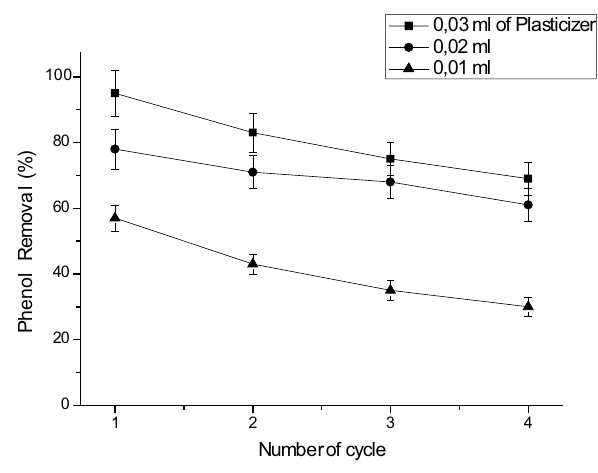
Fig. 7 Effect of plasticizer content on membrane stability. Transport conditions: feed phase: phenol 10 −3 M, pH 2. Stripping phase: NaOH 0.20 M. Membrane: 12.60 cm 2 of surface area, calix[4]resorcinarene: RC8 (0.15 g/g mixture of polymers), 2-NPOE(0.01–0.03 ml)/g mix- ture of polymers